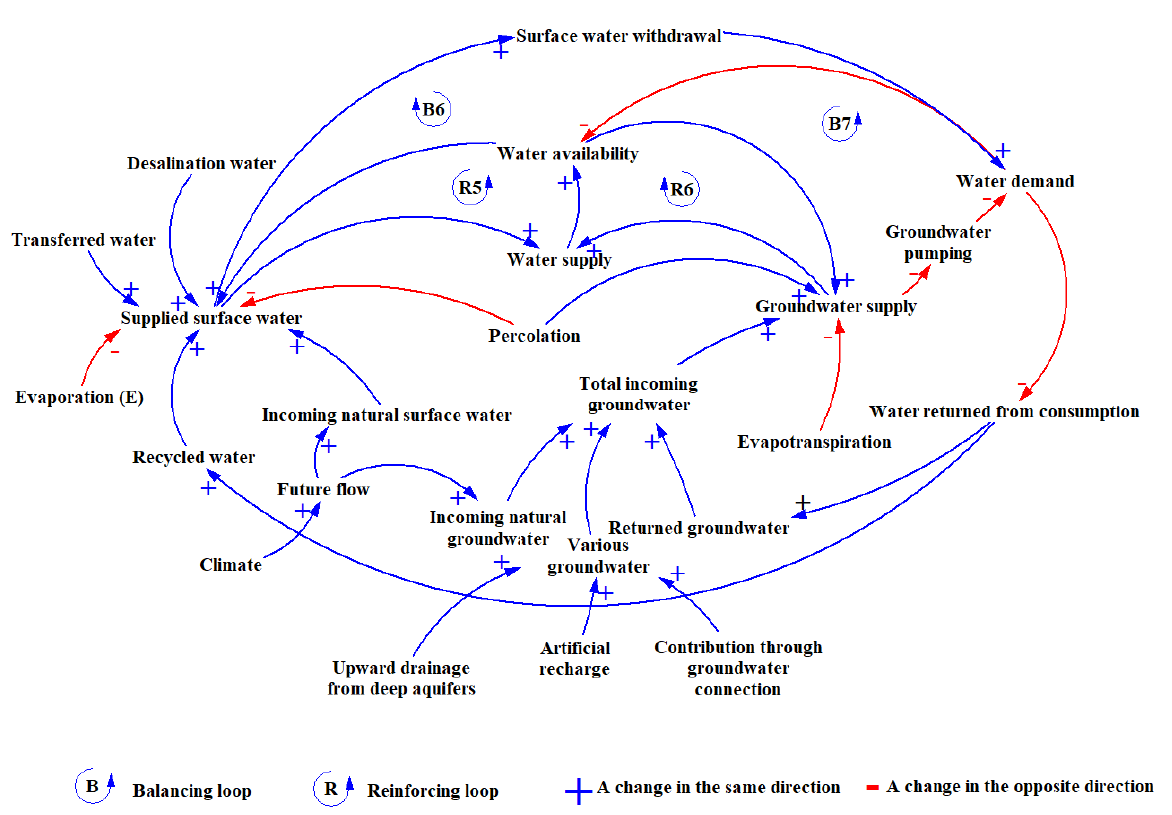
Figure 3. Causal loop diagram mapping the key parameters that impact water supply in the Souss- Massa basin.